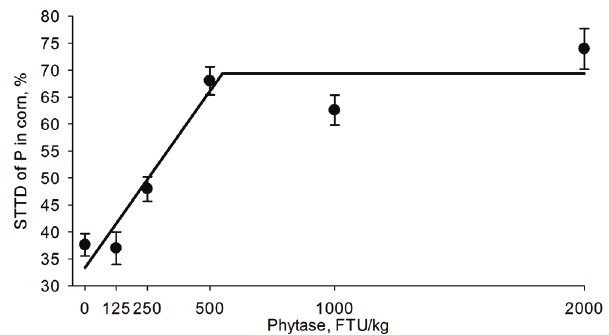
Figure 2. Fitted broken-line model of standardized total tract digestibility (STTD) of P in corn as a function of concentration of exogenous phytase in the diet. Treatment means ( ● ) and standard error are shown. It was calculated that a minimum of 550 FTU/kg of phytase was needed to obtain a STTD of P at a plateau of 69.4%. The linear equation before the break point was STTD of P = 33.4+0.0654×phytase dose in FTU/kg, r 2 = 0.95, p<0.001. FTU, phytase units.